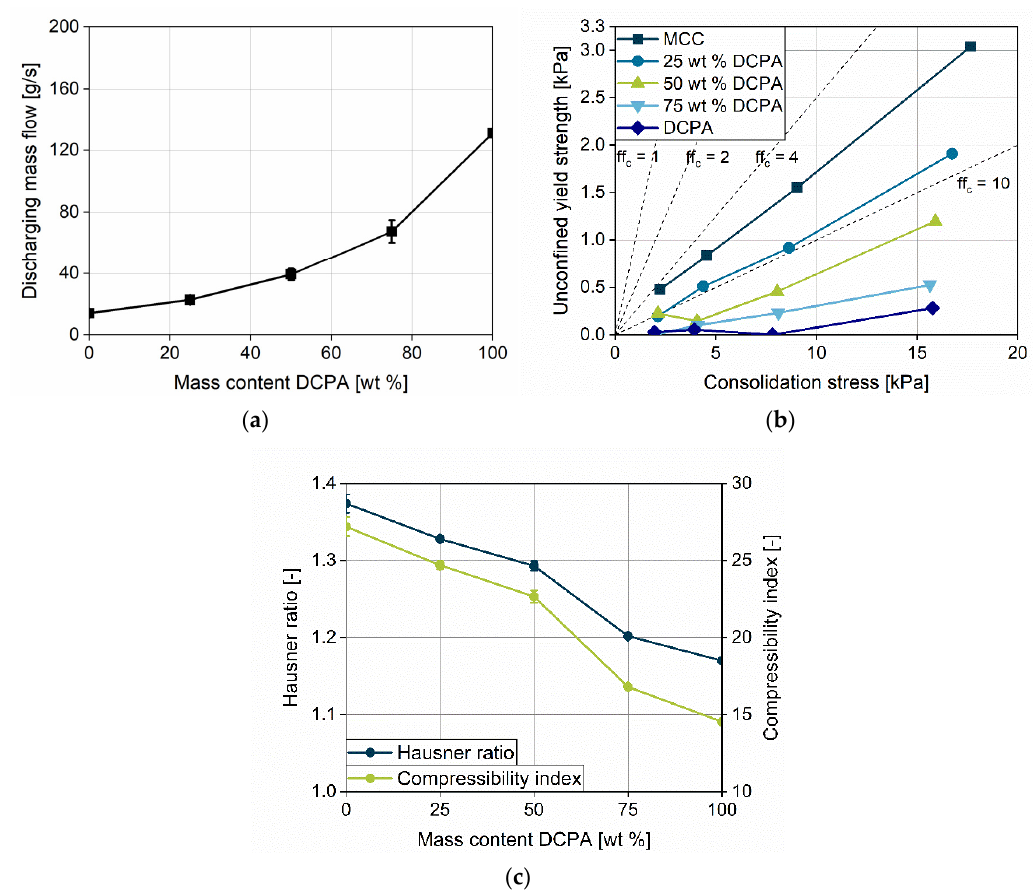
Figure 5. Flow properties of the powders used in this study; ( a ) Mass flow of powders, measured by granular flow tester; ( b ) Flow function ( ff c ) measured with ring shear tester; ( c ) Hausner ratio and Compressibility index for the five formulations used.